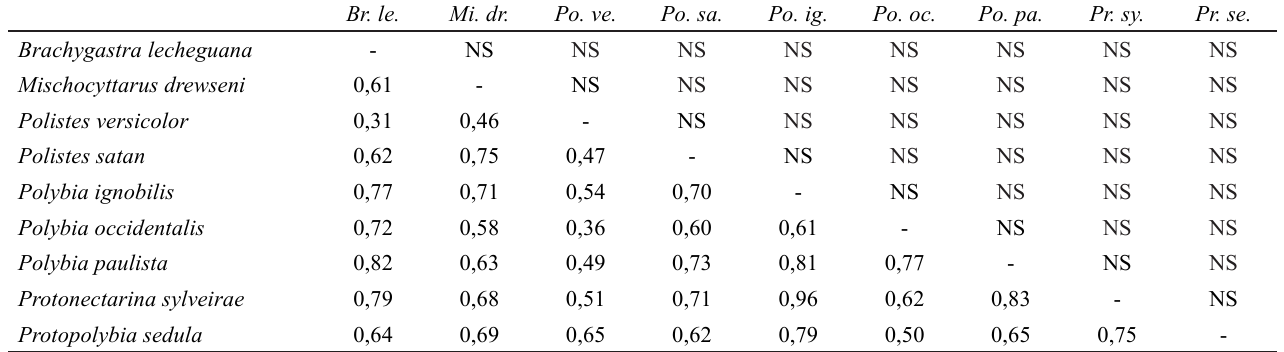
Polybia paulista